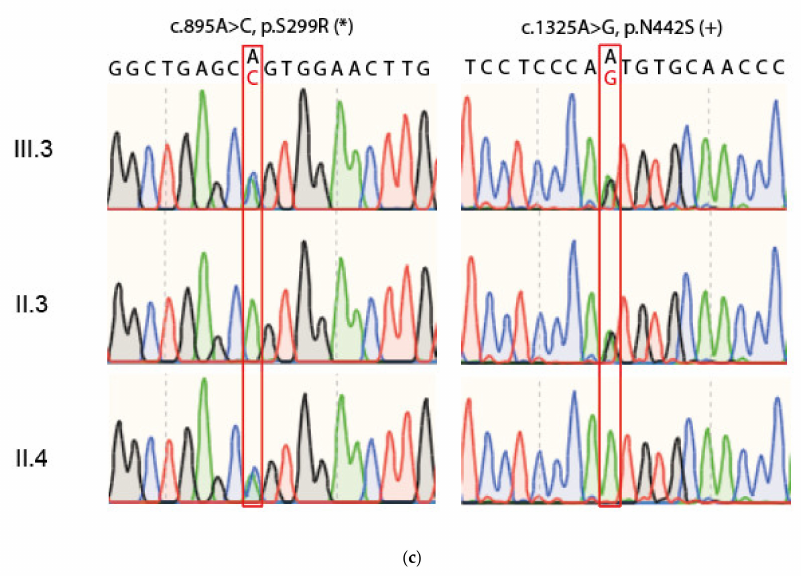
Figure 1. Pedigree and genotyping analysis. ( a ) Shown is the pedigree of the patient with the compound heterozygous FKTN variants. Circles represent females, and squares represent males. Affected individuals are shown as black-filled symbols. The index patient is marked with an arrow. † = deceased. The age of the patient at the time of ventricular assist device implantation (VAD), implantable cardioverter defibrillator implantation (ICD), or heart transplantation (HTx) is indicated (y = years). ( b ) Integrated genome view of parts of FKTN showing the variants identified in the index patient (III.3). The percentage of reads corresponding to the base identified at the relevant positions (c.895 and c.1325) is given (green = A, blue = C, orange = G). Below the reads, the genomic DNA sequence (gDNA) and the sequence of the translated protein (protein) are shown. ( c ) Electrophero- grams obtained by Sanger sequencing of the FKTN -regions with the particular variants. The index (III.3) patient carries both FKTN c.895A>C (p.S299R, *) and the c.1325A>G (p.N442S, +) variants (*/+ in A). The patient’s parents (II.3 and II.4) were heterozygous for one of the mutations ( − /+ or */ − in